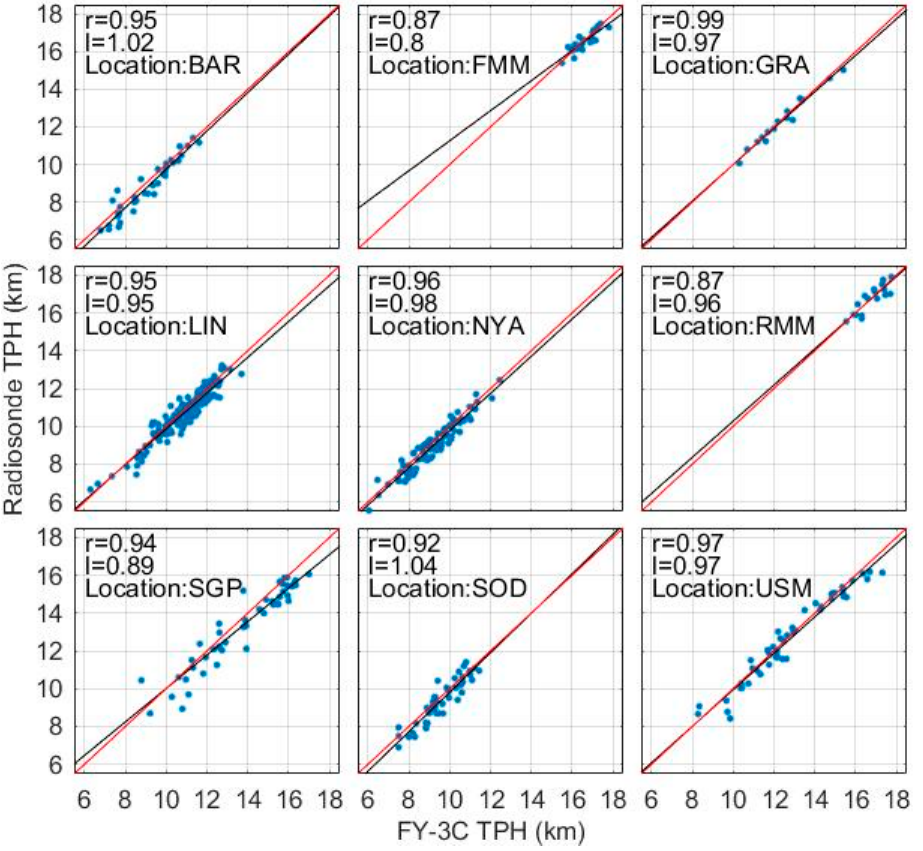
Figure 7. TPH comparison results of FY-3C and radiosonde data of nine stations. The x-axis (FY-3C TPH results) and y-axis (radiosonde TPH results) are symmetric and the correlation coefficient r and linear regression coefficient l are located at the top-left corner of each panel.